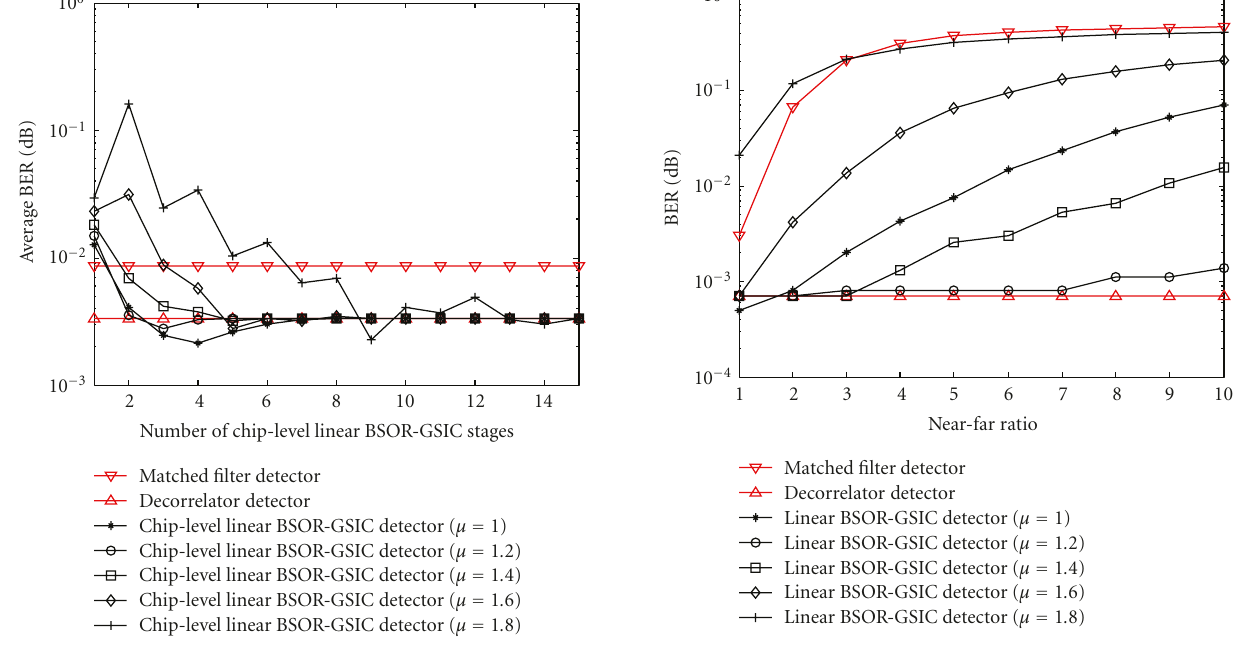
Figure 8: Near-far resistance of the chip-level linear BSOR-GSIC detector for di ff erent values of the relaxation factor ( G =